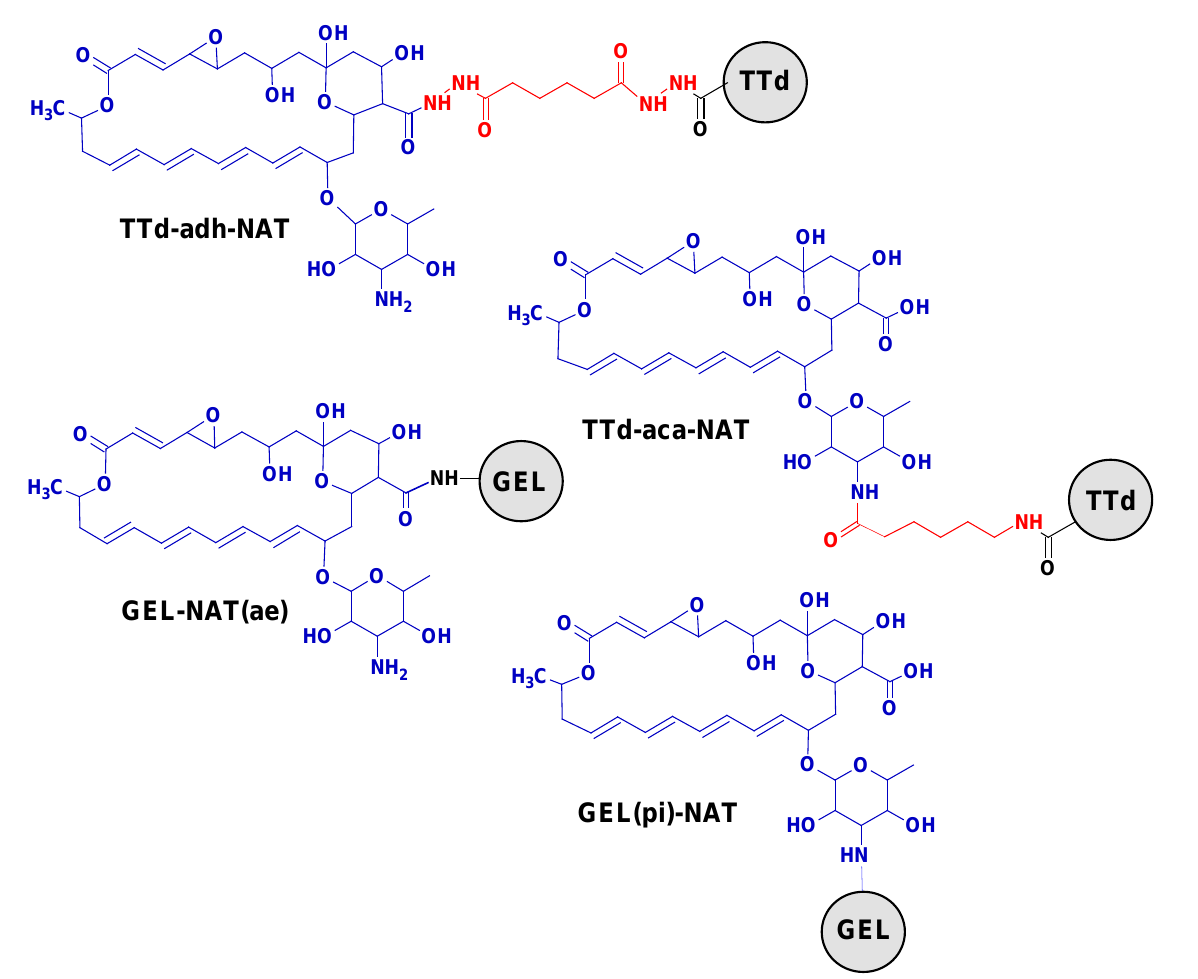
Figure 1. Structures of NAT-based immunogens and coating antigens for indirect competitive ELISA. NAT—blue; protein carrier—black; spacer—red.